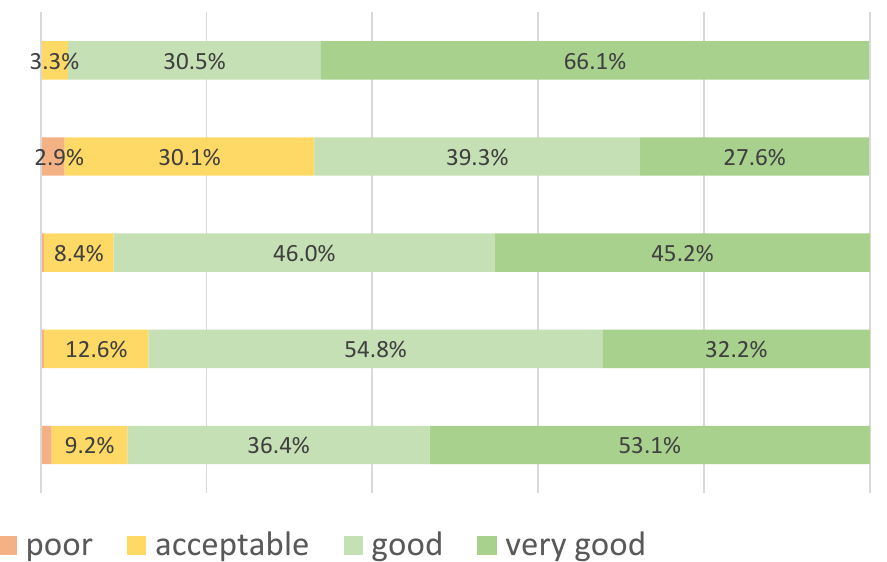
Figure 4. Evaluation of specific program elements of MobileCoach Alcohol . Values are presented for percentages >2%.